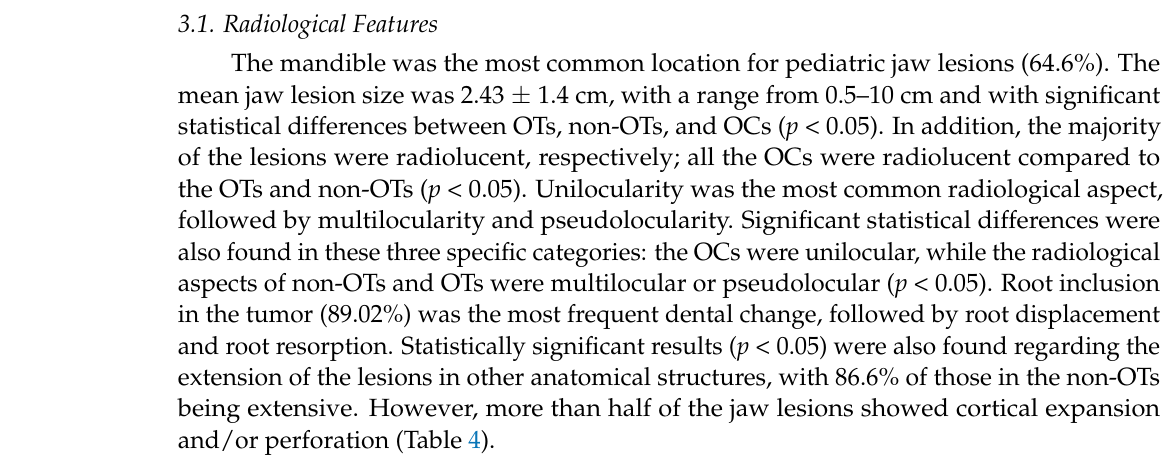
Table 4. Imagistic and radiographic analysis of jawbone